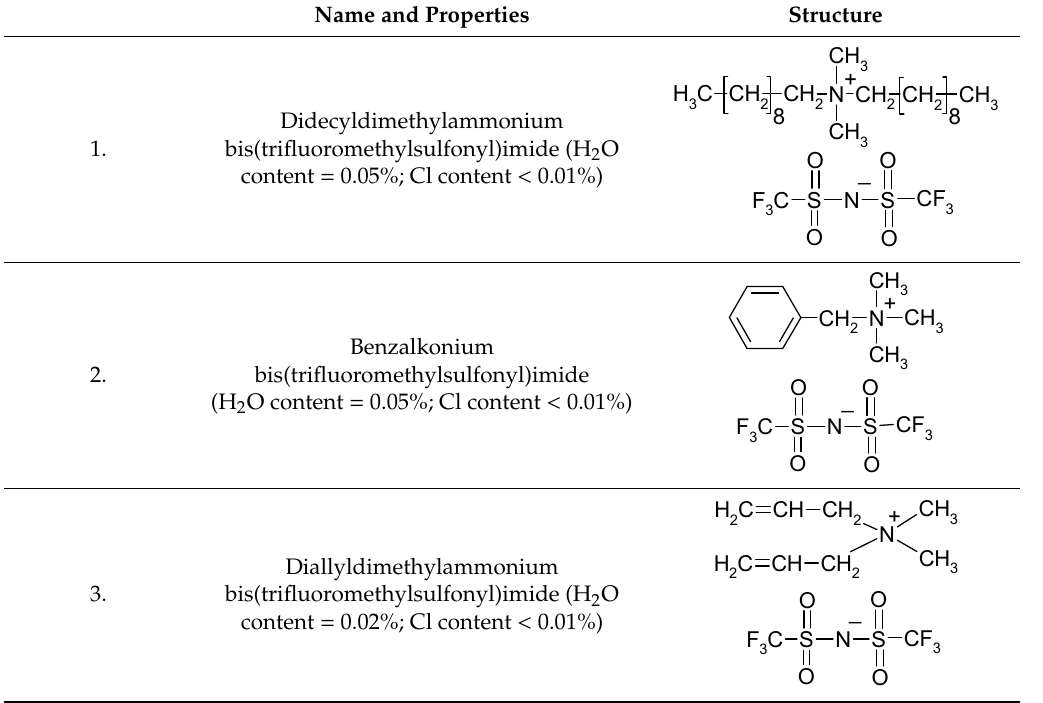
Table 1. Names, substantial properties, and structures of ionic liquids (ILs) used in the study. Name and Properties Structure